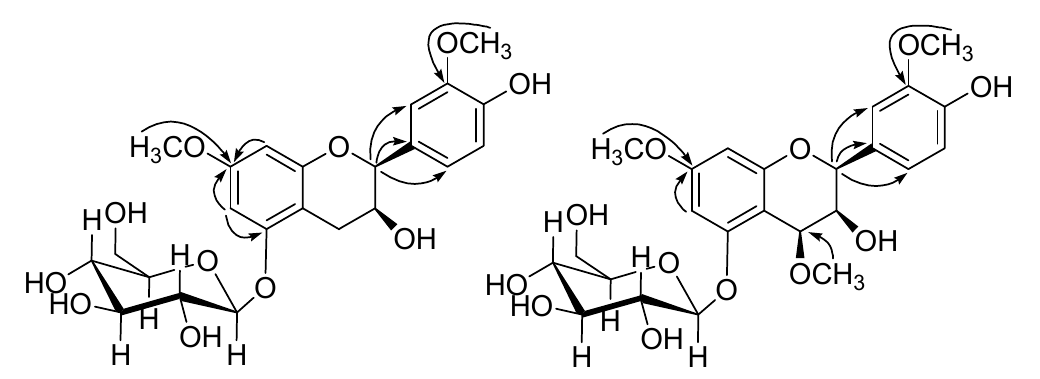
Figure 4. Key HMBC correlations of 3 and 4 .